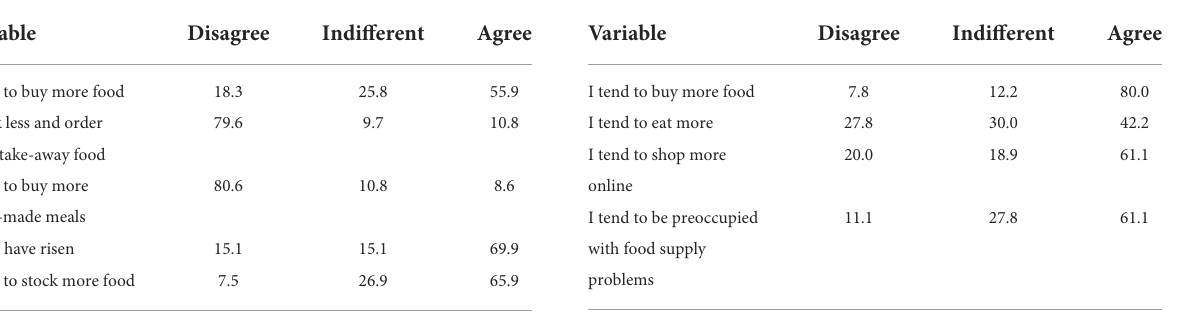
TABLE 6 Summary statistics of the main reasons for the increase in the amount of money spent on shopping.